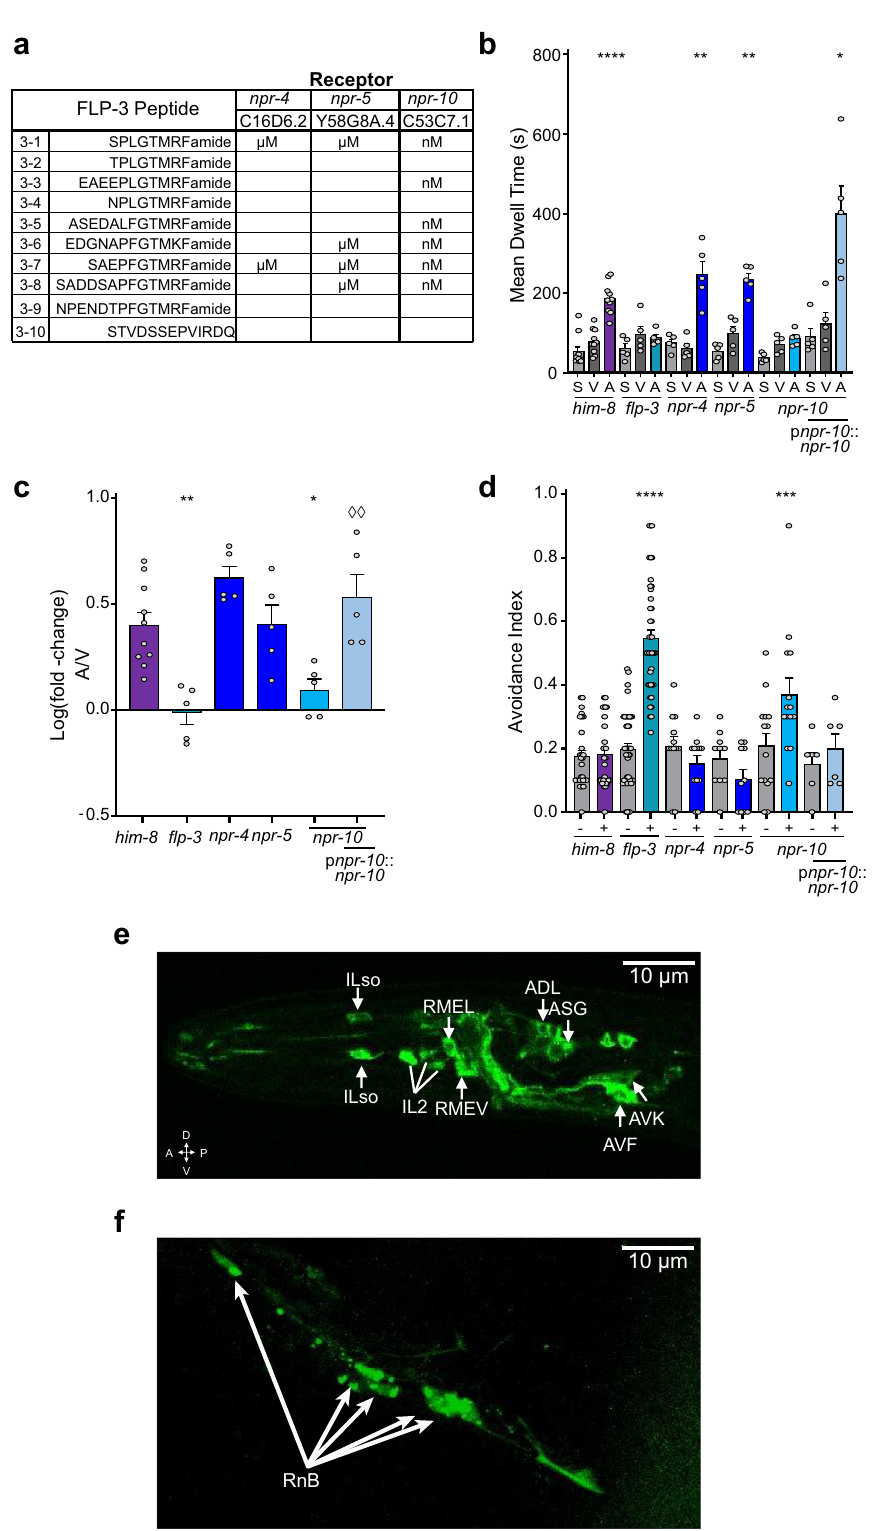
Fig. 3 The G protein-coupled receptor, NPR-10, is required for the male behavioral response to ascr#8. a FLP-3 peptide af fi nities for known receptors, adapted from Li and Kim, 2014 23 . b, c Male raw dwell time and log(fold-change) values for npr receptor mutants and npr-10 rescue in the SWAA, respectively. d npr-10 males exhibit increased avoidance to ascr#8 compared to the other receptors. Expression of npr-10 under its endogenous promoter rescues the avoidance phenotype. e Localization of p npr-10 :: npr-10 ::GFP in the amphid region of the male head. Neurons expressing npr-10 include the inner labial neurons, IL2, and their respective socket cells (ILso), the interneurons RMEV and RMEL, the chemosensory neurons ADL and ASG, as well as the interneurons AVF and AVK. f Expression of p npr-10 :: npr-10 ::GFP in the mail tail. Localization is observed in the B-class Ray neurons. ♂ denotes male